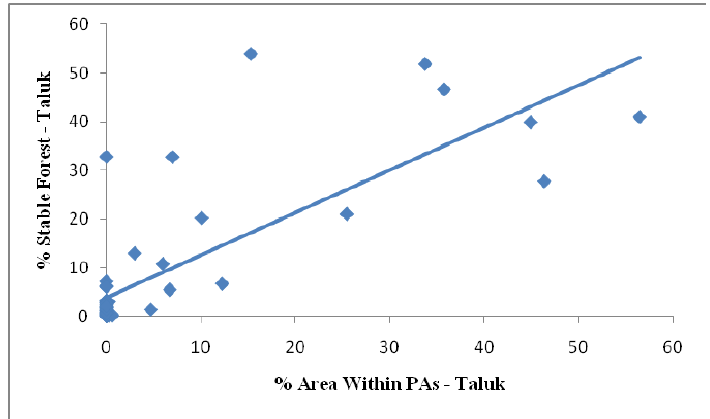
Figure 14b. Relationship between percentage of area within PAs and the distribution of stable forest for